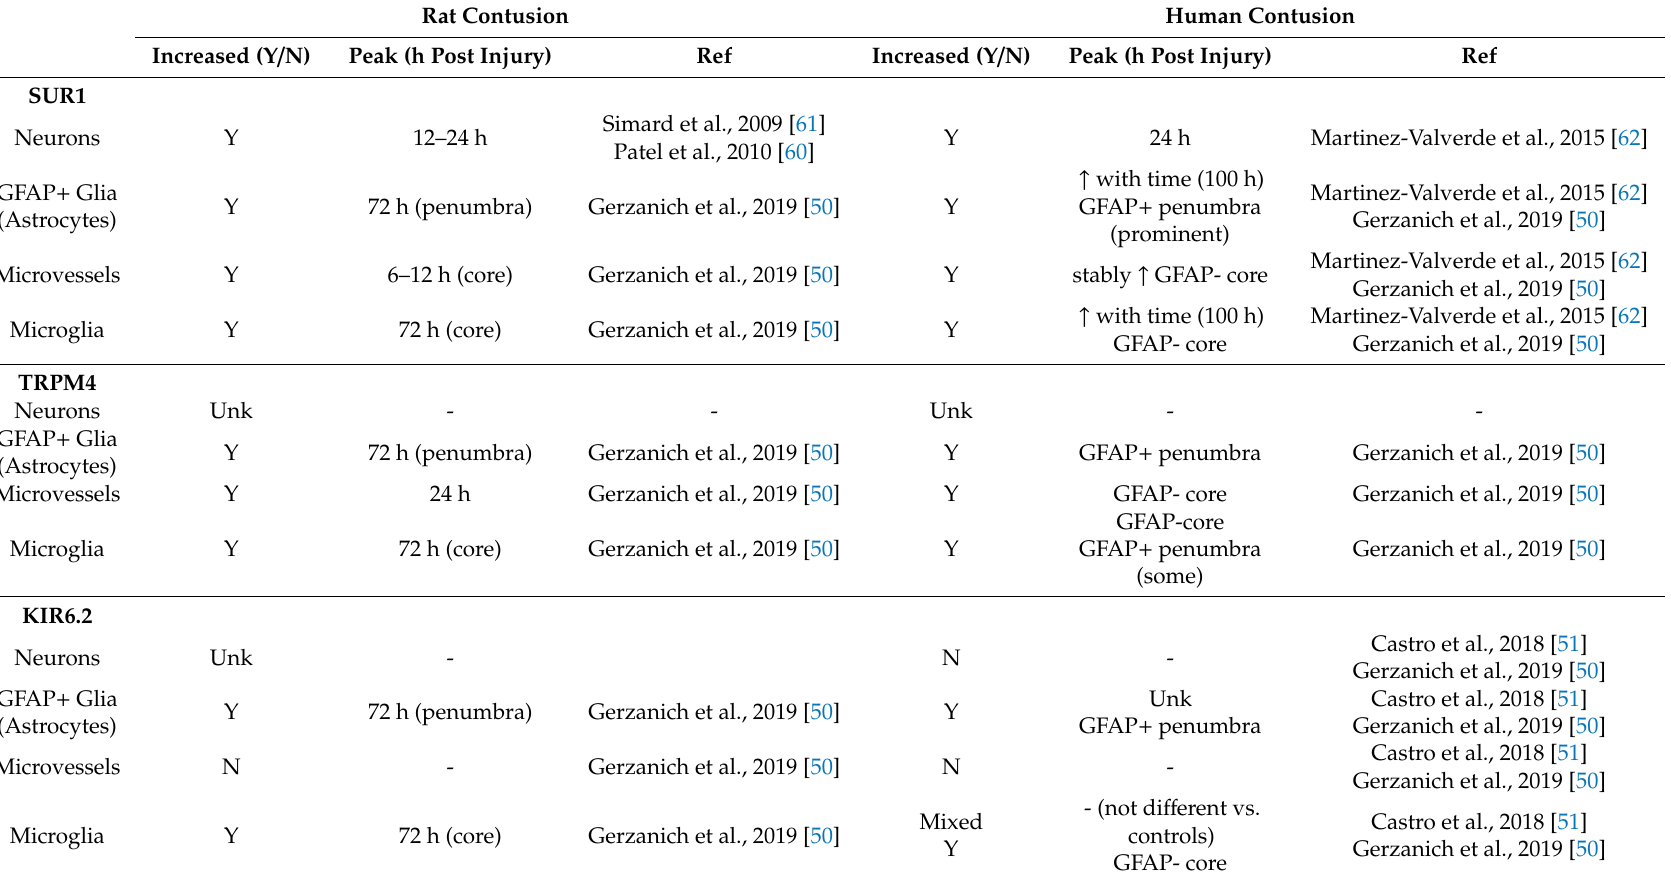
Table 1. SUR1, TRPM4, and KIR6.2 expression in rodent and human contusional